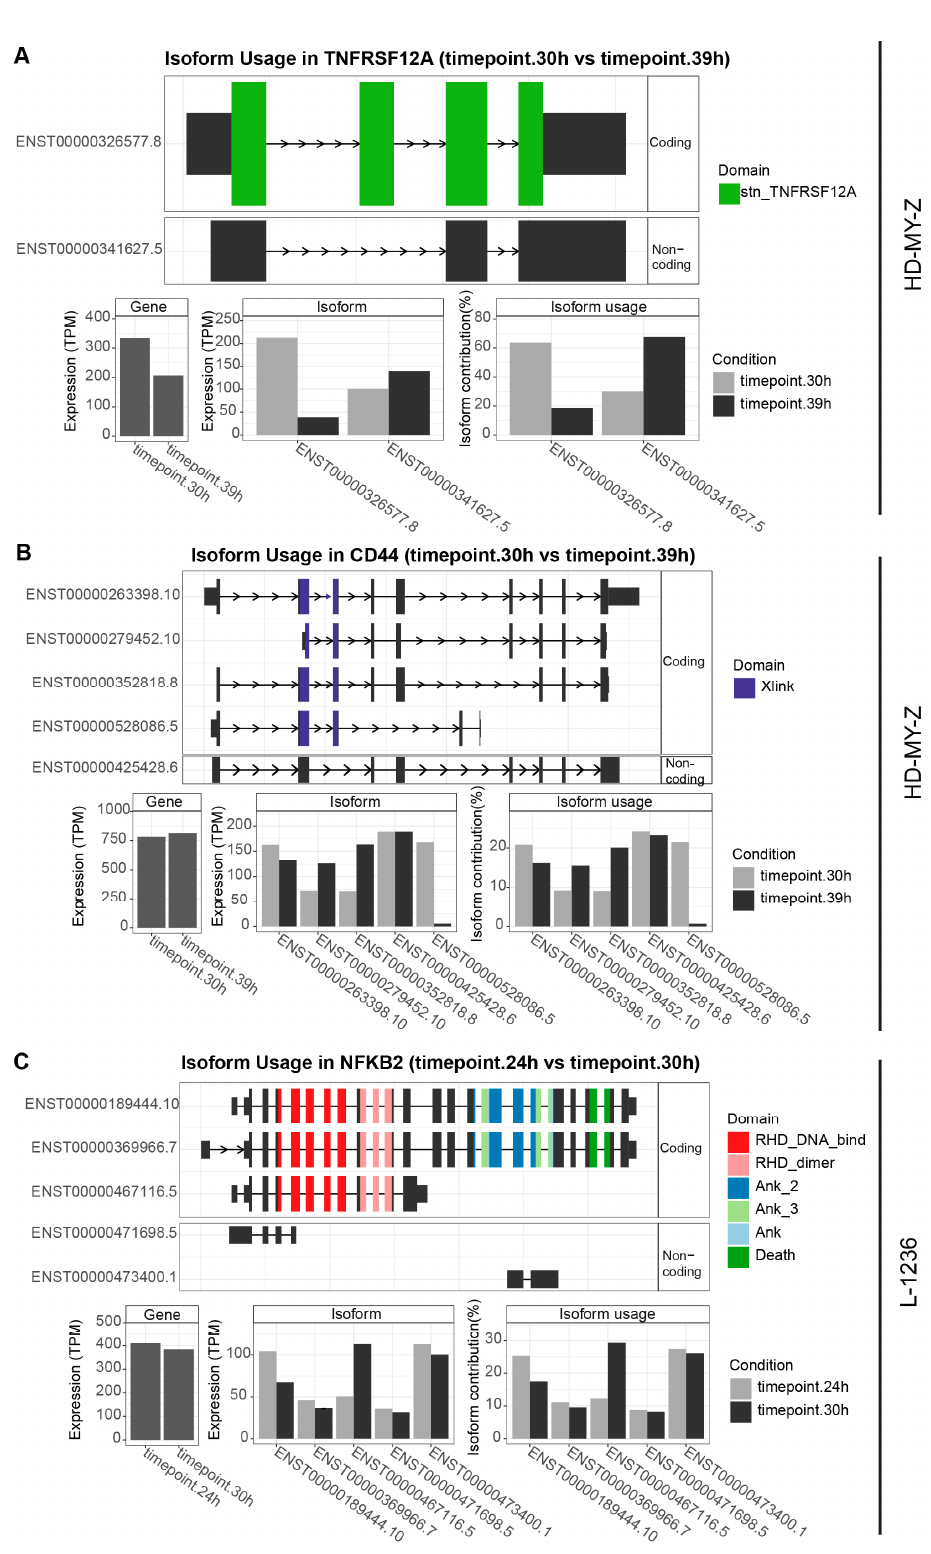
Figure 6. Genes related to the TNF signalling pathway show switching between isoform expression with potential functional implications. ( A ) Based on the analysis of switching behaviour